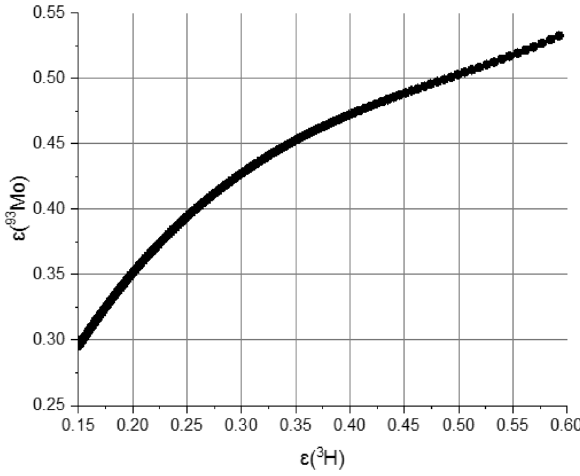
Figure 6. Computed 93 Mo counting efficiency vs. 3 H counting efficiency to apply the CNET method.